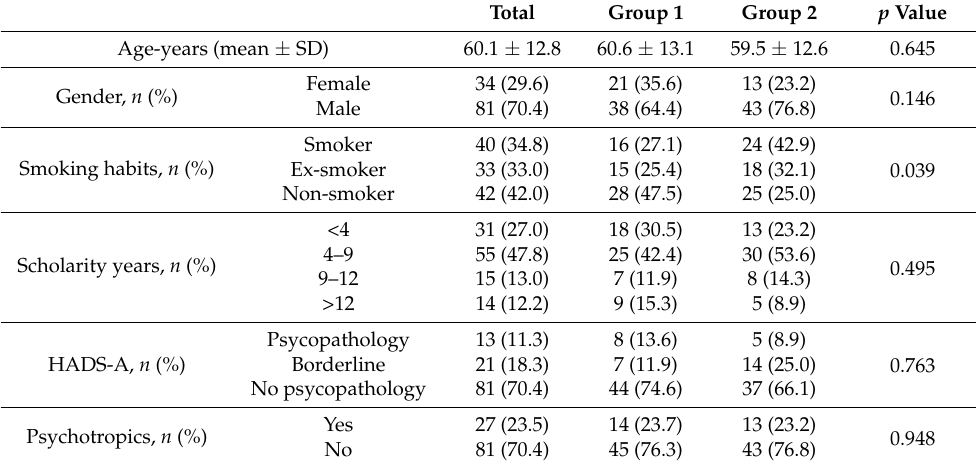
Table 1. Baseline patient characteristics.